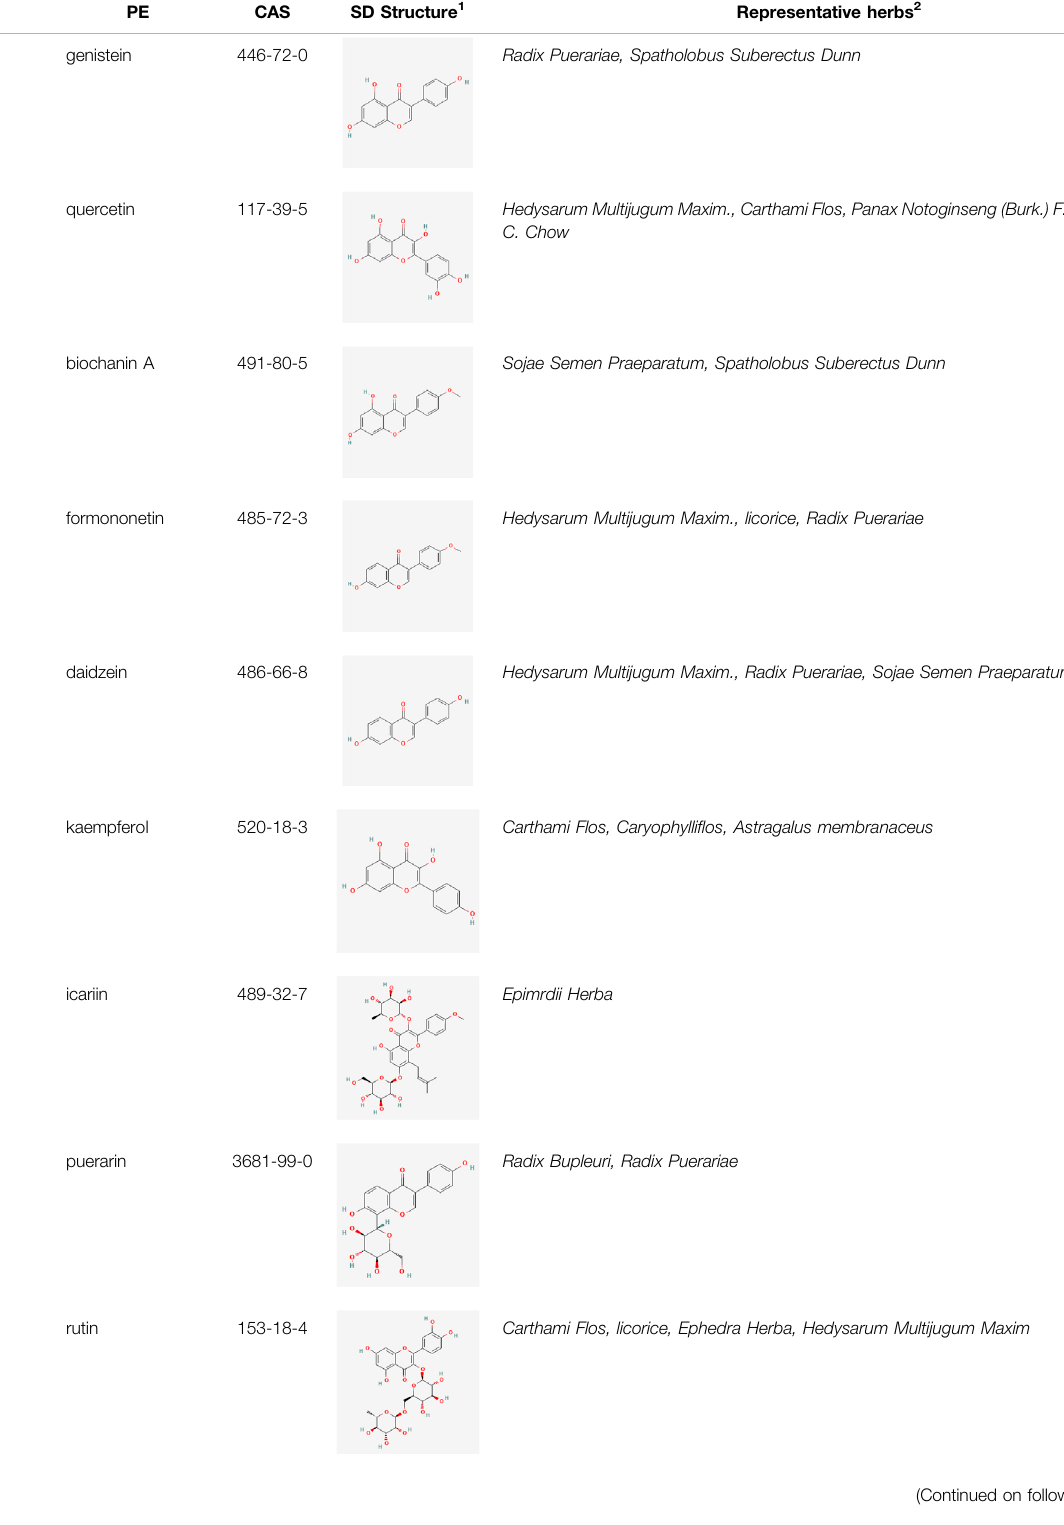
TABLE 1 | Phytoestrogens that have been experimentally proven to be effective against